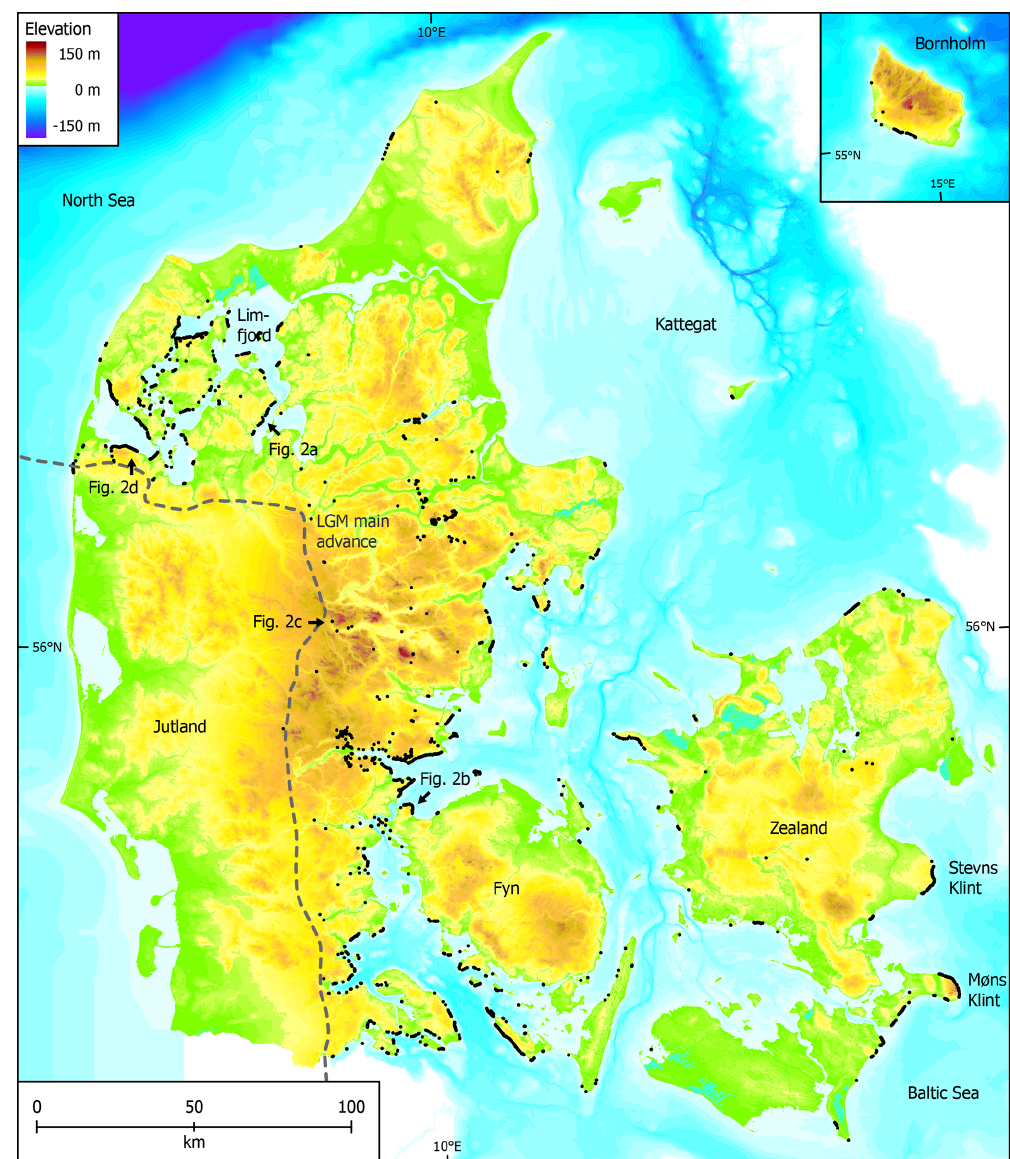
Figure 1. Landslide inventory plotted over a land and sea elevation map of Denmark. The black dots show 3202 mapped landslides. The dashed line indicates the last glacial maximum (LGM) main advance from the northeast during the Weichsel glaciation (Houmark-Nielsen, 2011). Place names mentioned in the text along with positions of panels in Fig. 2 are